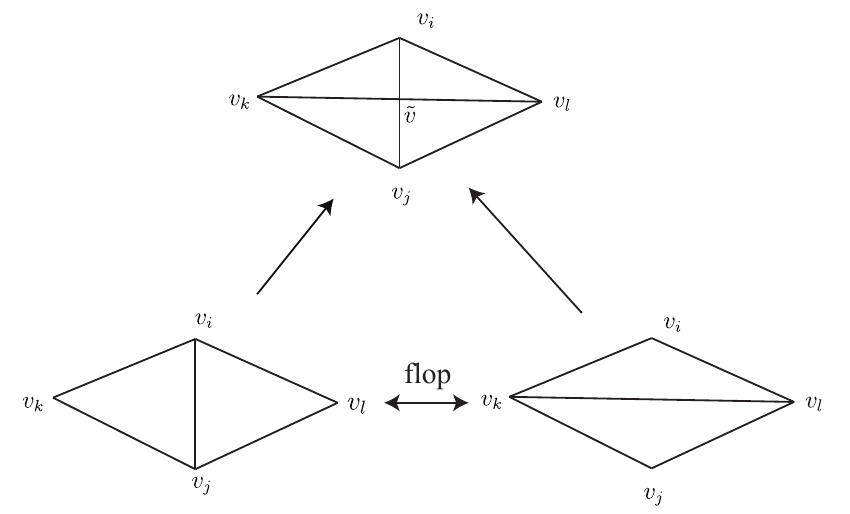
Figure 10 . An illustration of the (cid:13)op process, which can happen when v i + v j = v k + v l